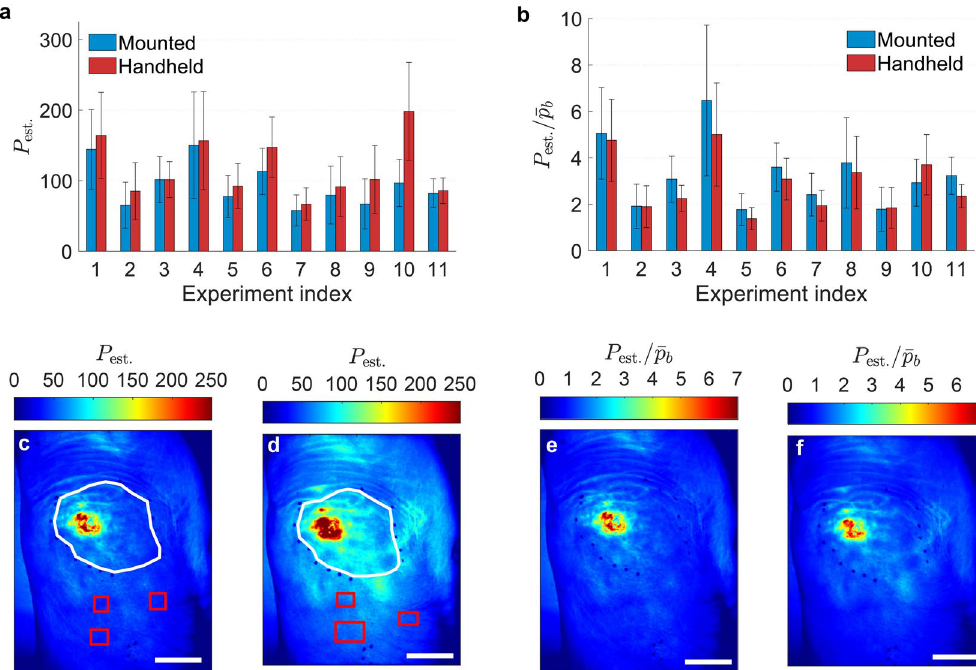
Figure 8. Visualization and statistical comparison between temporally averaged and background corrected perfusion maps per pairs of mounted and handheld experiments. Overview of average perfusion over the entire lesion for ( a ) temporally averaged and ( b ) background corrected perfusion maps. P est. : estimated perfusion; ¯ P b : background perfusion. Data are reported as mean±standard deviation. Representative temporally averaged perfusion maps of ( c ) mounted and ( d ) handheld measurements of experiment index 9. Red rectangles: ¯ P b ) are calculated. White polygons: manually manually selected regions in which background perfusion values ( selected lesion areas. Background corrected perfusion maps of corresponding ( e ) mounted and ( f ) handheld measurements. Scale bars, 25